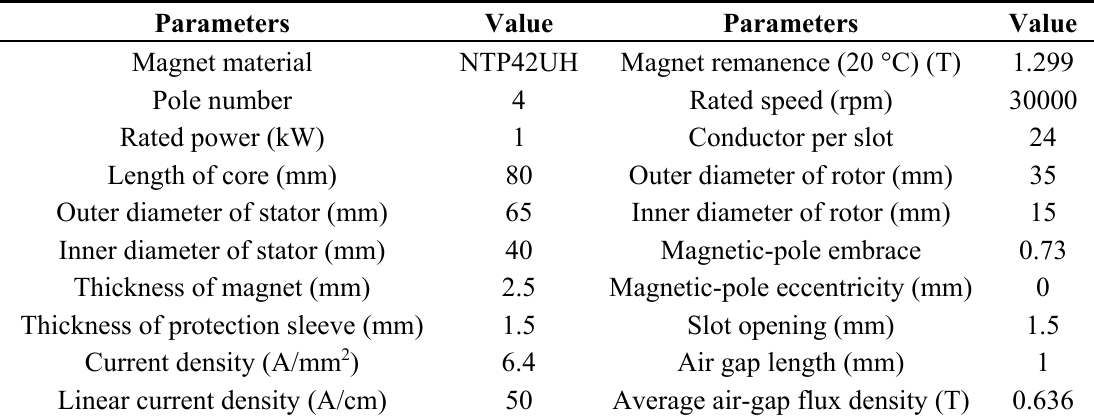
Figure 3. Flux line distribution of the two structures: ( a ) SPM and ( b ) IPM. Table 3. Initial parameters of the